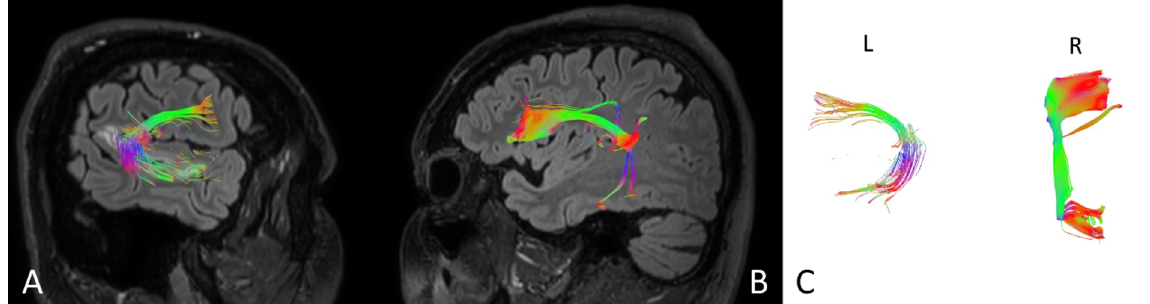
Figure 4. Anatomy of the arcuate fasciculus (AF) upon the patient’s admission to the hospital. ( A ) right hemisphere, ( B ) left hemisphere, ( C ) comparison of left and right axial plane of AF.